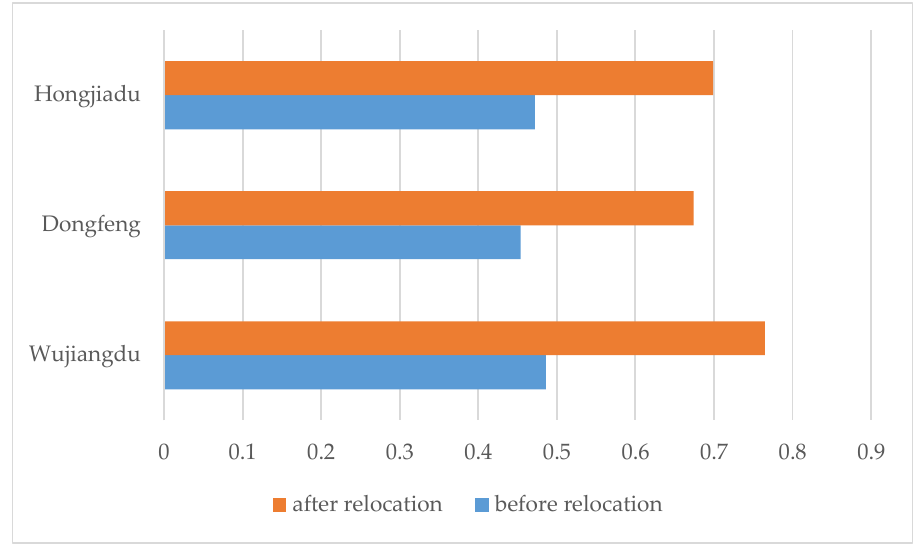
Figure 3. Sketch map of the comprehensive assessment score of the Wujiangdu, Dongfeng, and Hongjiadu Power Stations.